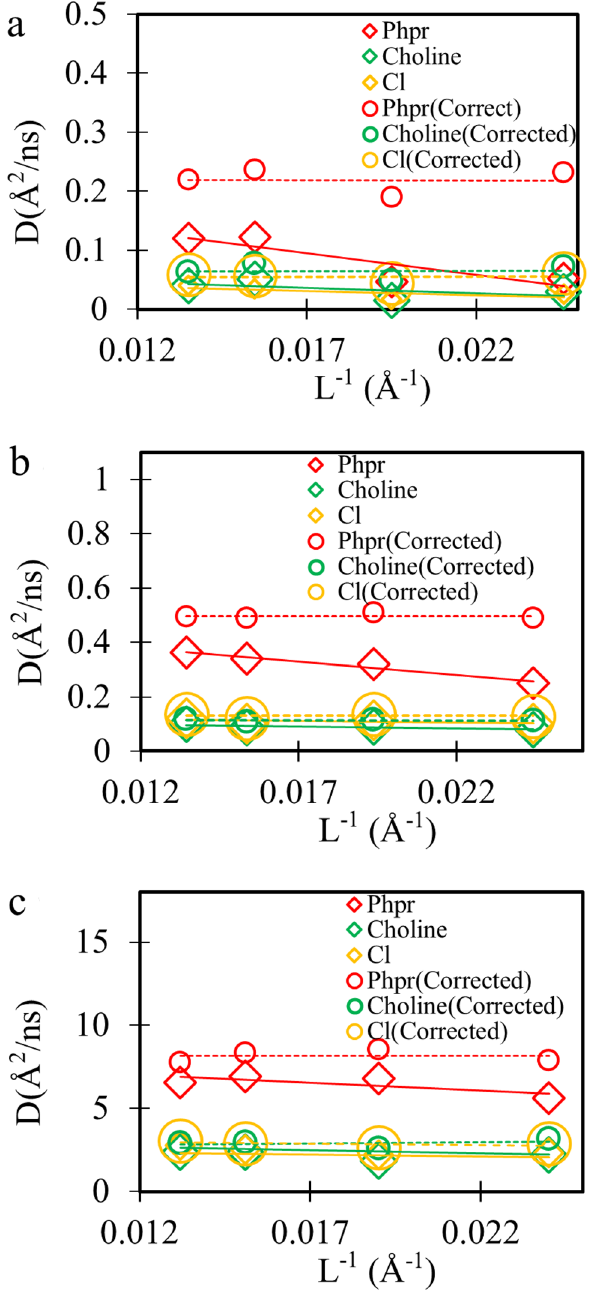
Figure 11. The self-diffusion coefficient of DES species as a function of invers box length at ( a ) 293 K, ( b ) 321 K, and ( c ) 400 K. The uncorrect self-diffusion coefficient ( D MD i,self ) from MD simulations are depicted as diamonds, and the solid lines are the extrapolation to the thermodynamic limit ( D ∞ i,self ). The corrected self- diffusion coefficient using Eq. (6) are shown as circles, and the dash lines are the extrapolated values. These plots were drawn by Gnuplot 5.2.6 (http:// www. gnupl ot.